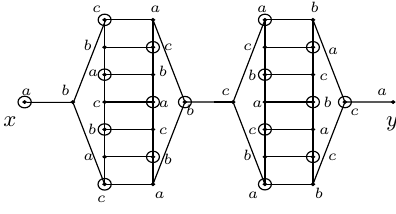
Figure 3: The graph E ( x, y ) : any linear 3-coloring c of E ( x, y ) verifies: c ( x ) = c ( y